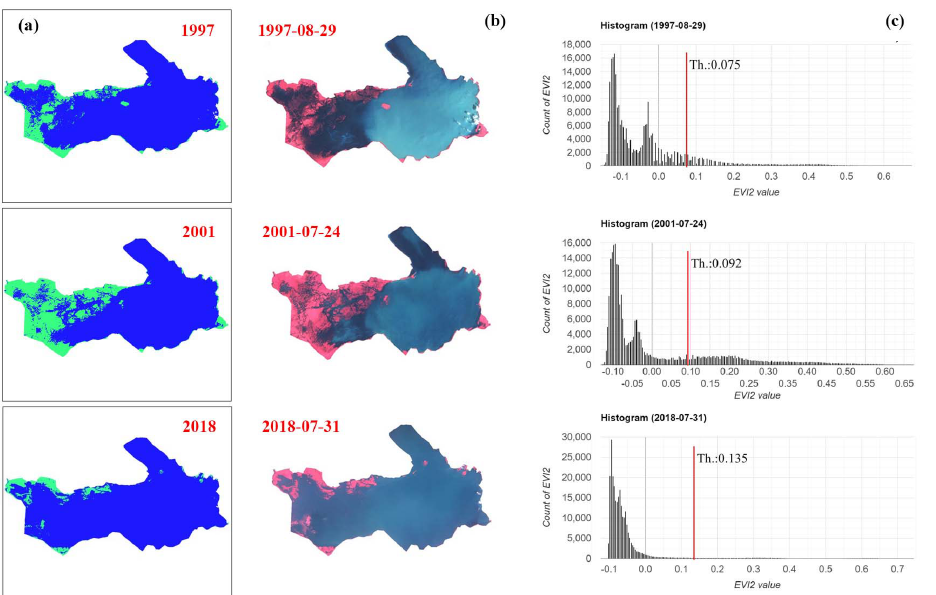
Figure 4. Classification results based on the optimized threshold for 1997, 2001, 2018. The pixels with EVI2 values below and above the selected threshold were assigned as water and aquatic vegetation, respectively. ( a ) Classification results; ( b ) The false color composite images; ( c ) EVI2 histogram and the Otsu segmentation thresholds.